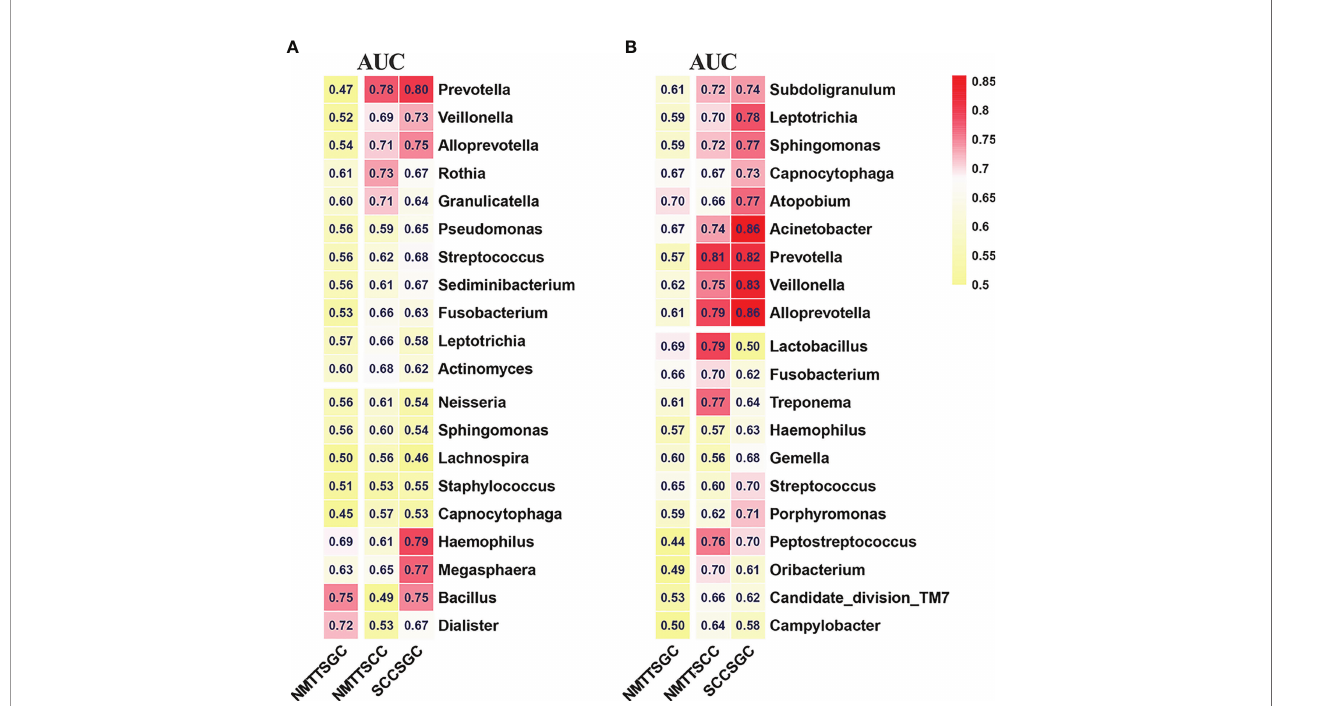
FIGURE 6 | Differences in bacterial genera among NMTT, SGC, and SCC groups in trachea (A) and lung alveoli (B) sites. The receiver operating characteristic curves for classi fi cation were performed and the values of the area under the ROC curve (AUC) are shown in the